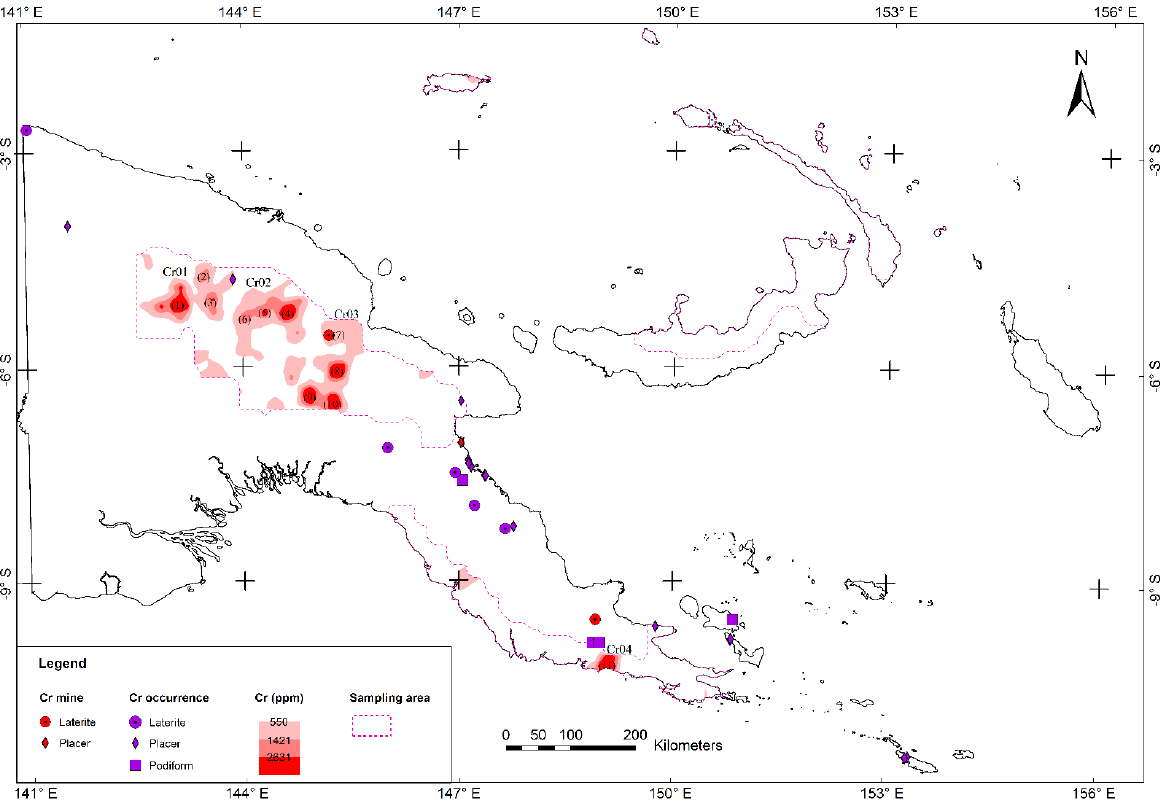
Figure 5. Chromium geochemical anomaly map of PNG.